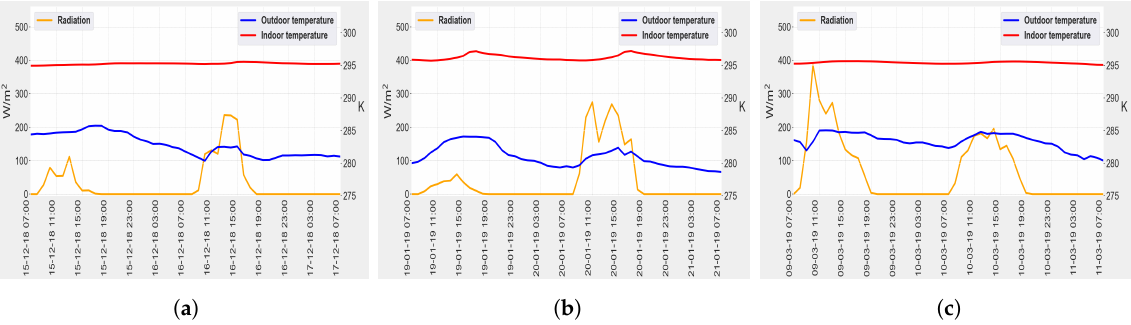
Figure 4. Summary of the thermal conditions of each of the validation samples: ( a ) Sample 1; ( b ) Sample 2; ( c ) Sample 3. Solar radiation and indoor and outdoor temperatures affecting the analysed building during the specific time periods are represented.